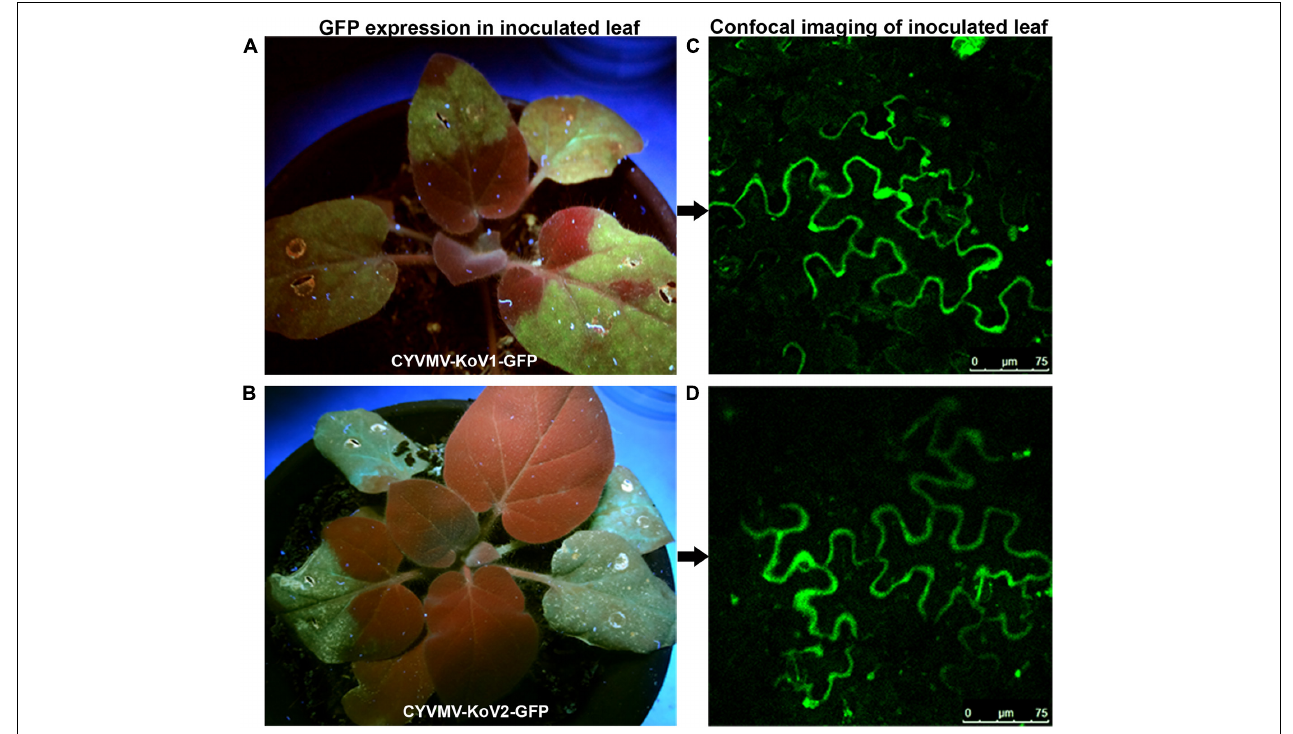
FIGURE 9 | GFP-fused CYVMV V1 (CYVMV-KoV1-GFP) and V2 (CYVMV-KoV2-GFP) deletion constructs were created for individual N. benthamiana leaf infiltrations. GFP expression evidenced through epifluorescence (A,B) and confocal imaging (C,D) . Deletion of either V1 or V2 restricted GFP signals within the infiltration sites.